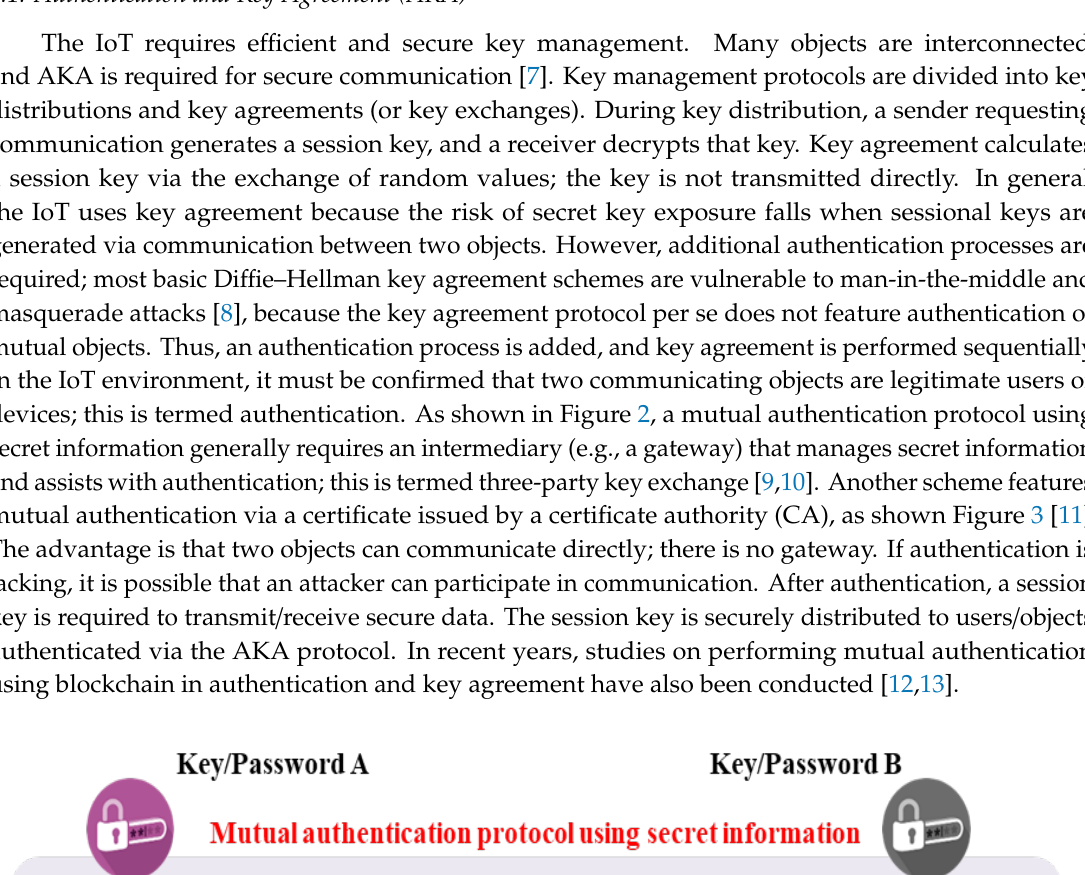
Figure 3. Mutual authentication flow with certificate.